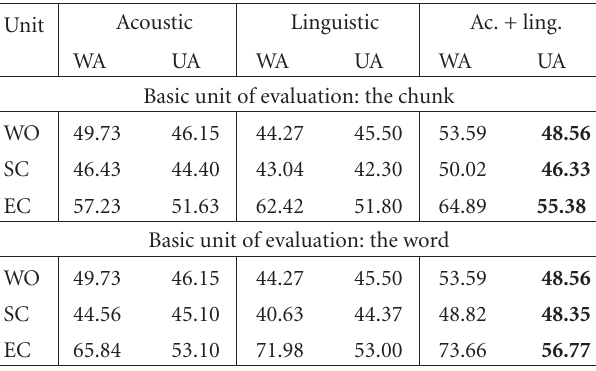
Table 7: Evaluation in percent correct; (un-)weighted average recall (UA/WA). Note that the chunk- and the word-based evaluations of word units coincide; words can be seen a the smallest possible chunk. Unit Acoustic Linguistic Ac. + ling.